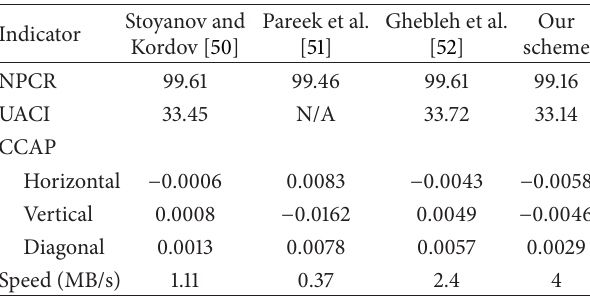
Table 4: Performances’